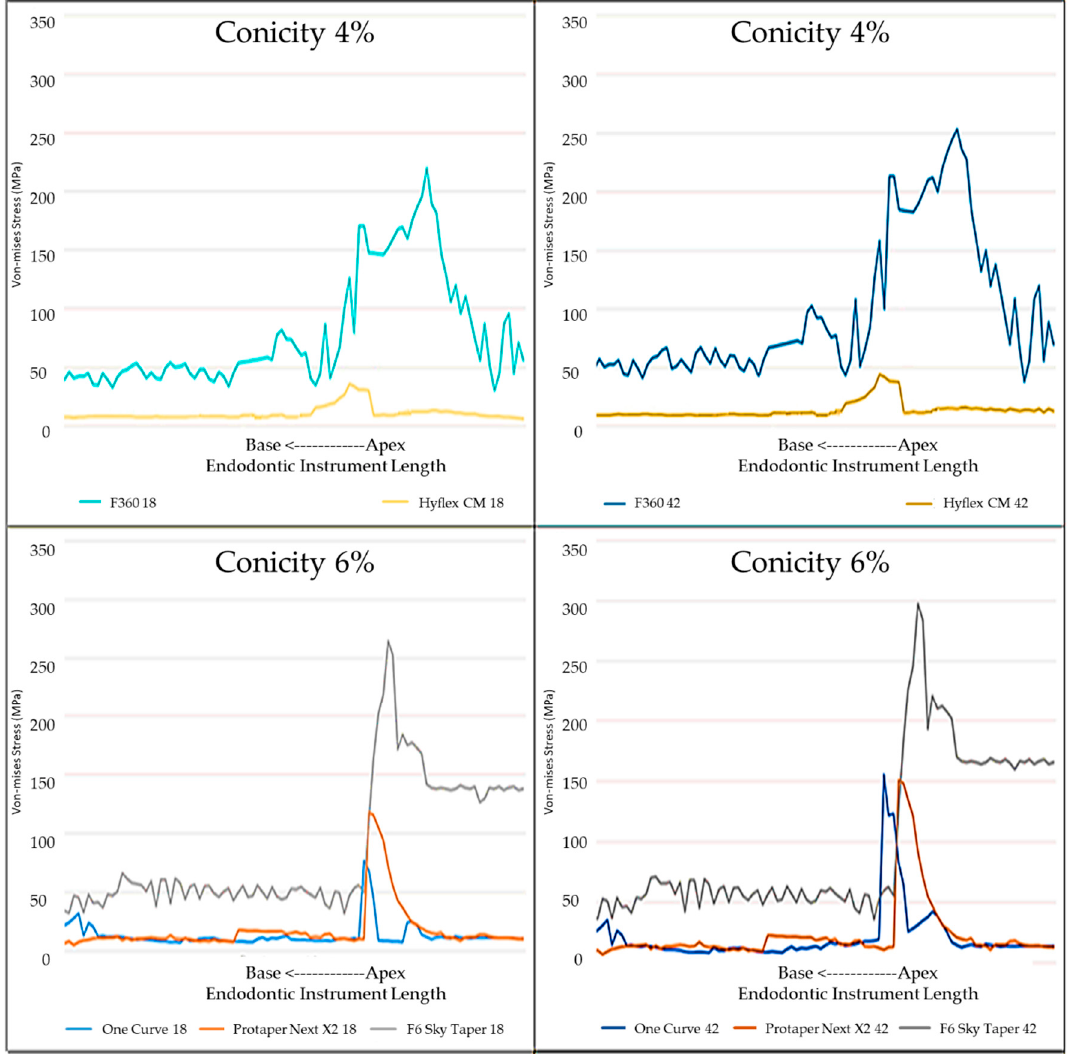
Figure 7. Von Mises stress distribution along the endodontic instrument length, from the base to the apex, according to the elastic modulus of the canal dentine (18 GPa—left or 42 GPa—right).